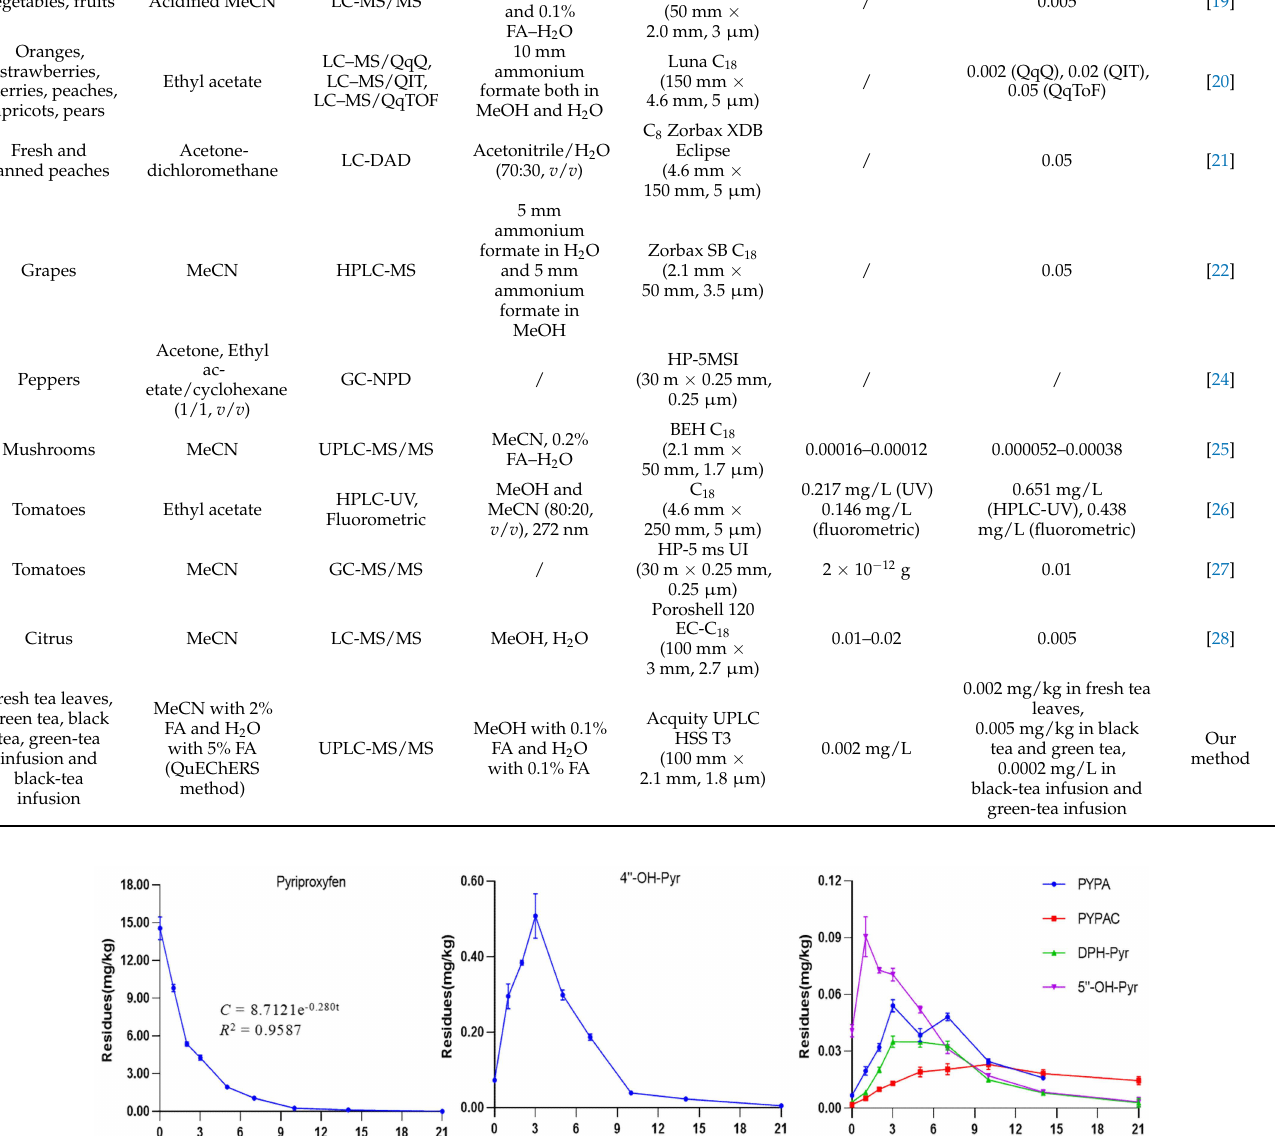
Figure 4. The dissipation trends of pyriproxyfen and its five metabolites on fresh tea leaves after application of 100 g/L pyriproxyfen